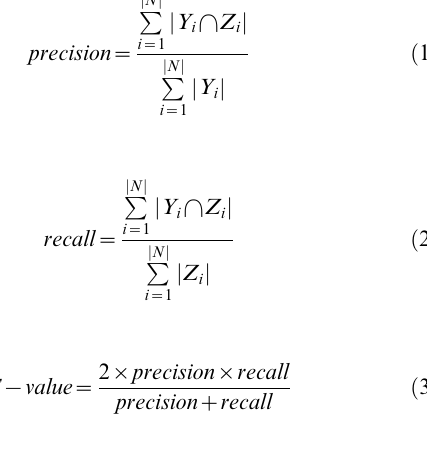
Table 1 contrasts the numbers of positive and negative training samples for the flat classification and top-down classification, which are acquired by calculating the average numbers for all GO